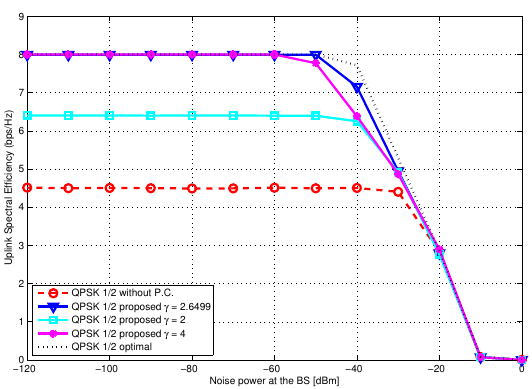
Figure 10. Spectral efficiency for QPSK-1/2 versus noise power with different values of γ .